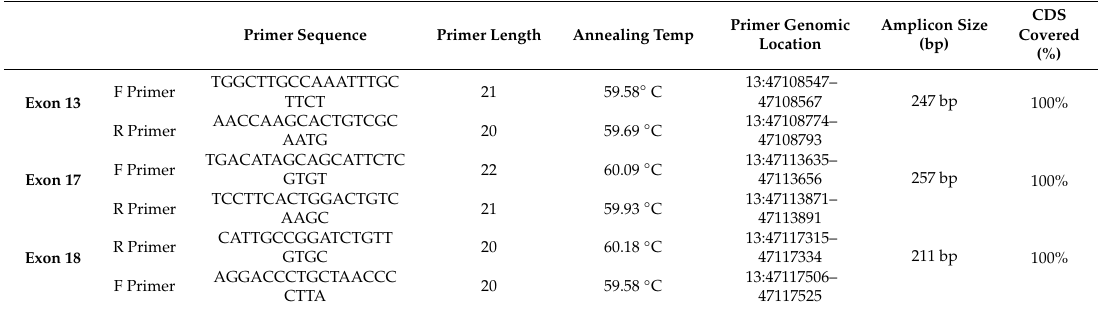
Table 2. Primers designed for the amplification of exons 13, 17, and 18 of the KIT gene with the relative lengths. CDS: Coding DNA Sequence; F: forward; R: